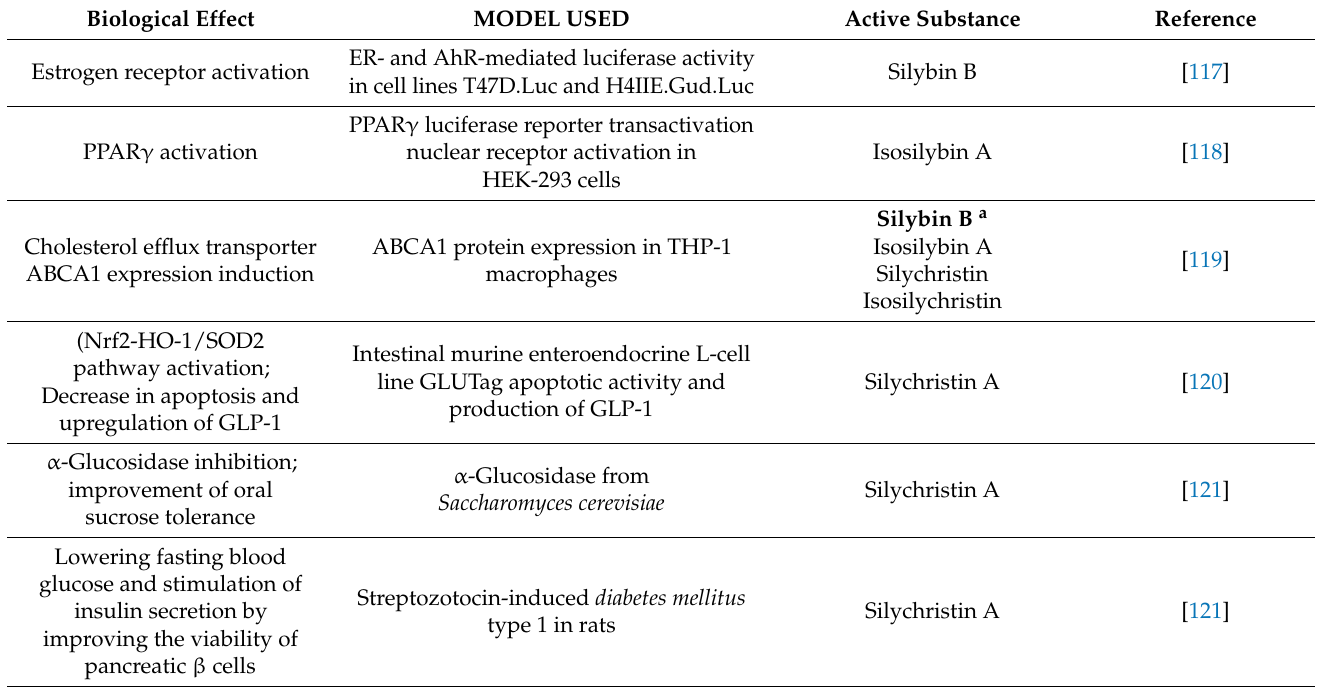
Table 1. Biological effects of optically pure silymarin flavonolignans and